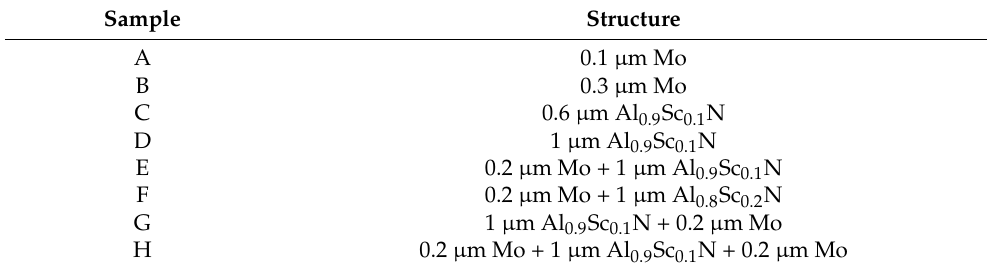
Figure 3. Schematic diagram of a picosecond laser pulse device and change of reflectivity after thermal background subtraction. Measurement points on wafer map is (0,0) (30,0) (60,0) (90,0). Unit is mm. Table 1. Experimental sample